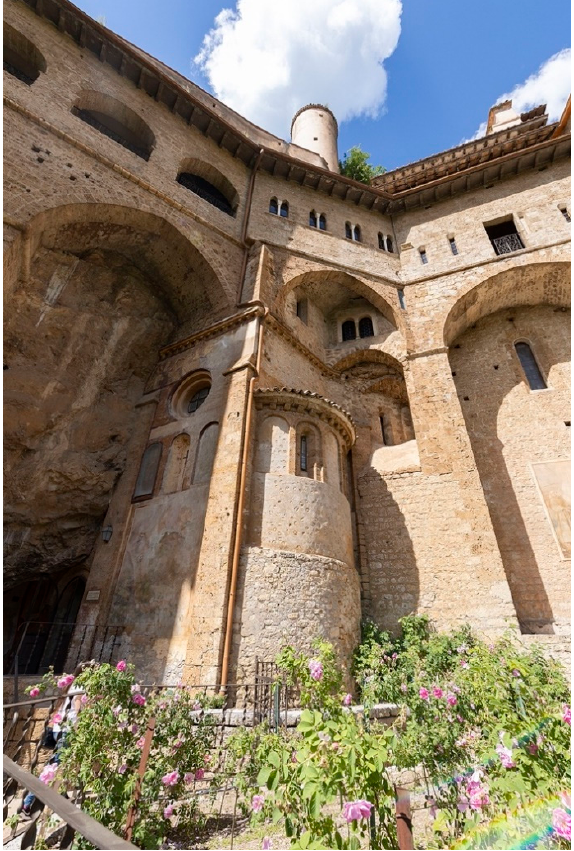
Figure 3. Sacro Speco, Subiaco (Italy). Exterior view with the Chapel of the Virgin. Photo: Davide